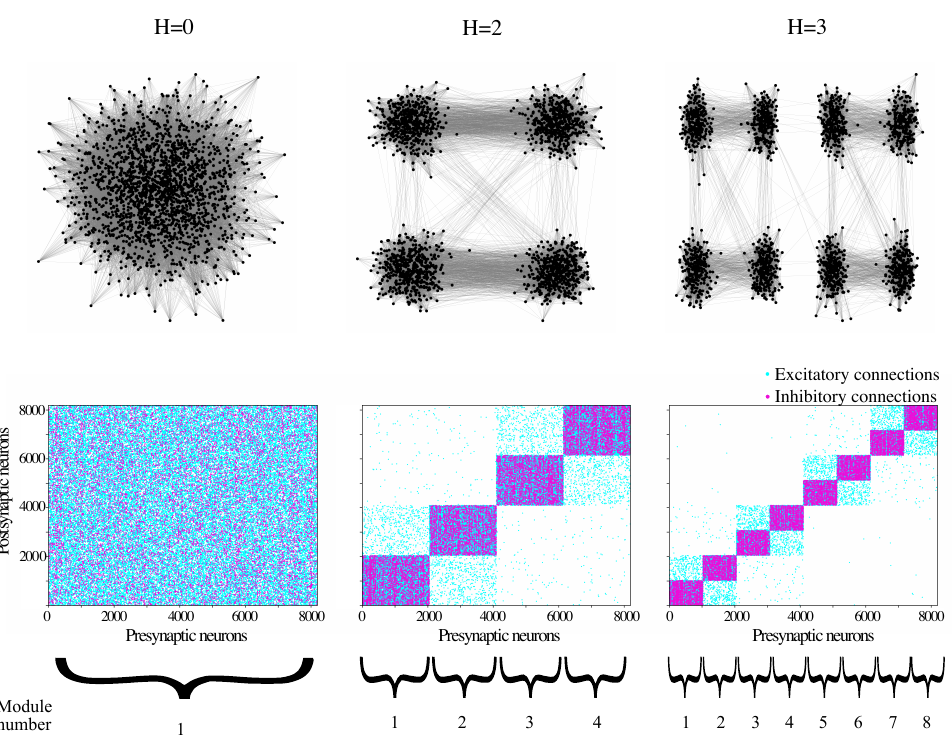
Figure 1. Examples of hierarchical modular networks of different hierarchical levels. (Upper row) Schematic representation of the network for H = 0, 2, and 3. In the figures, only networks with N = 2 11 and exclusively excitatory neurons were used for the ease of visualization and to highlight the intermodular connections. (Bottom row) Adjacency matrices for networks with N = 2 13 neurons (excitatory and inhibitory in the 4:1 ratio) and the same H levels as in the top row. Each dot represents a connection from a presynaptic neuron to a postsynaptic neuron. Blue dots represent excitatory neurons, and red dots represent inhibitory neurons. For each hierarchical level H , the module numbers are shown below the corresponding adjacency